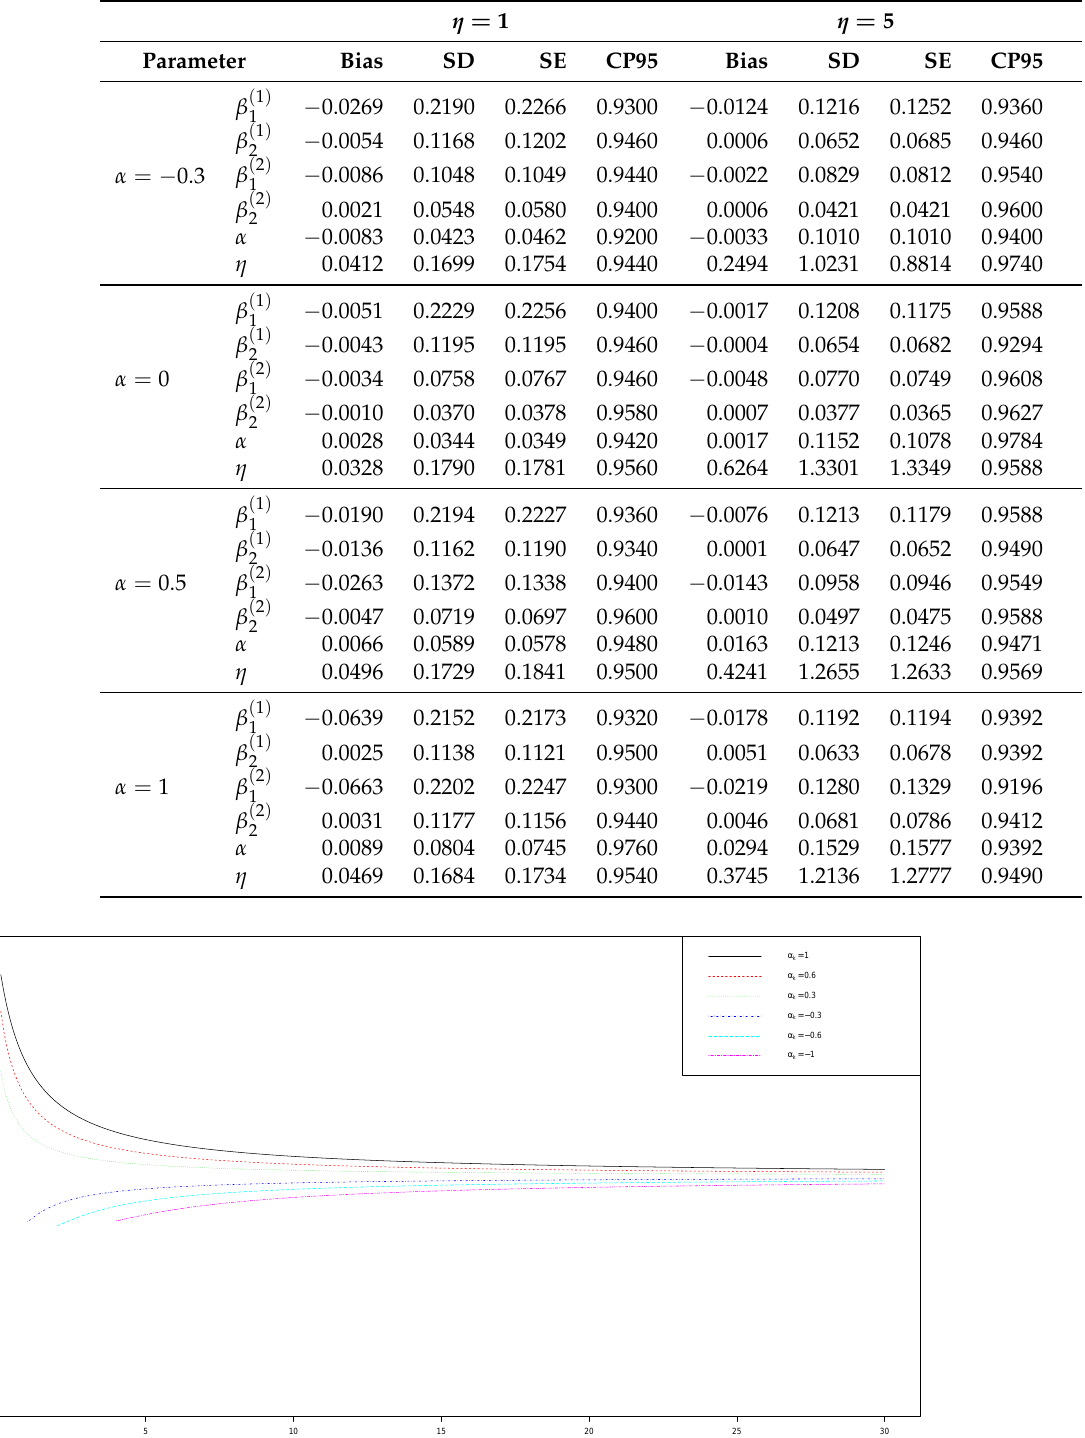
Table A2. Simulation results: estimation of regression coefficients α and η from our proposed method for data generated with different α values and true β Bias refers to the difference between the average of the 500 posterior means and the true value; SD refers to the mean of the 500 posterior standard deviations; SE refers to the standard deviation of the 500 posterior means, and CP95 refers to the 95% coverage probability.